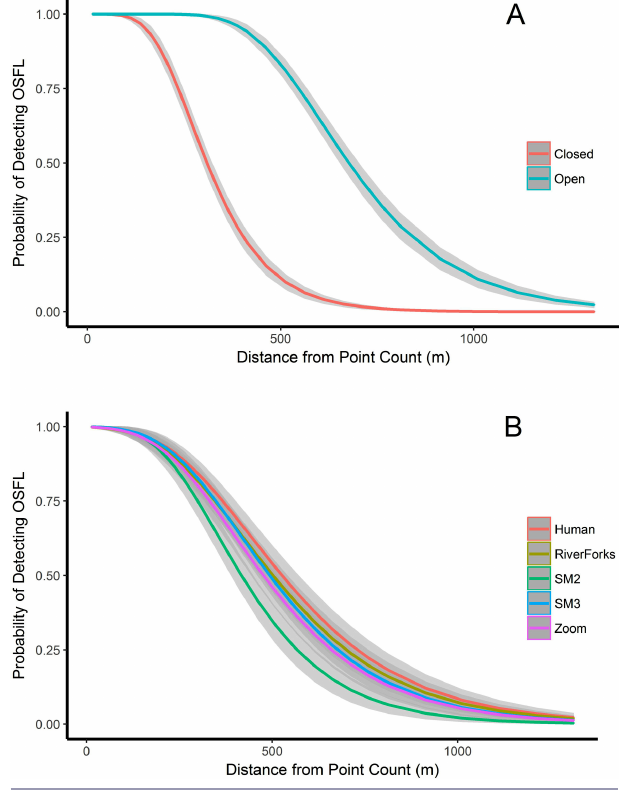
Fig. 1 . Probability of detecting OSFL with distance from ARU in (A) open (roadside) and closed (forested) habitat, and (B) with human observers, RiverForks, SM2, SM3, and Zoom recorders. Predictions are calculated from binomial detection data and plotted with 95% confidence